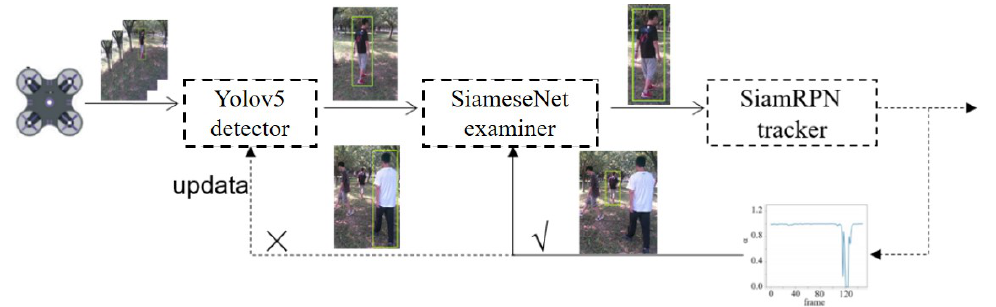
Figure 2. DTE-tracker